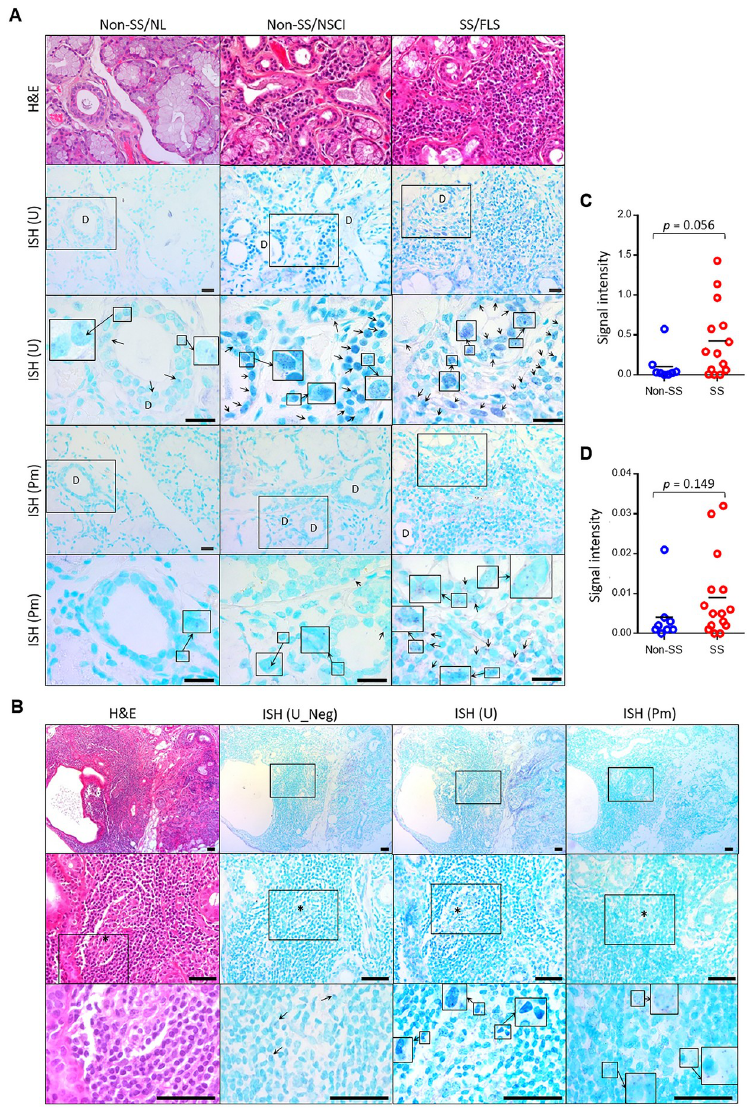
Fig 3. The presence of bacteria, including P . melaninogenica , within ductal cells and the infiltration areas of LSGs. The sections of paraffin-embedded LSG tissues obtained from non-SS subjects or SS patients were subjected to H&E staining and in situ hybridization (ISH) using universal (U) or P . melaninogenica -specific (Pm) probes. As the negative control (Neg), sections were hybridized with a probe mixed with a 10-fold amount of unlabeled probe. (A) Representative areas of normal (NL) histology, nonspecific chronic inflammation (NSCI), and focal lymphocytic sialadenitis (FLS) are shown. Selected areas (square) were examined with higher magnification. Arrows indicate ISH signals in violet color and the shape of rod or cocci. D, duct. Scale bars indicate 25 μ m. (B) A represented area of FLS with a germinal center (GC)-like structure is shown. The light zone is marked with � . Arrows indicate ISH signals in violet color with the shapes of rods or cocci. Several strong ISH signals were not completely inhibited in the negative control. Scale bars indicate 50 μ m. (C and D) The signal intensities of ISH performed using the universal (C) or Pm- specific (D) probes were